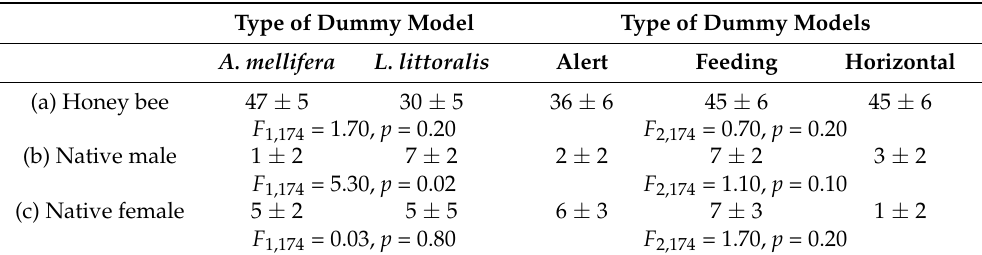
Table 2. Percentages of time spent on floral visits ( M ± SE ) of Opuntia huajuapensis with model bees of A. mellifera and L. littoralis native bees (male and female) and three-body position treatments of dummy